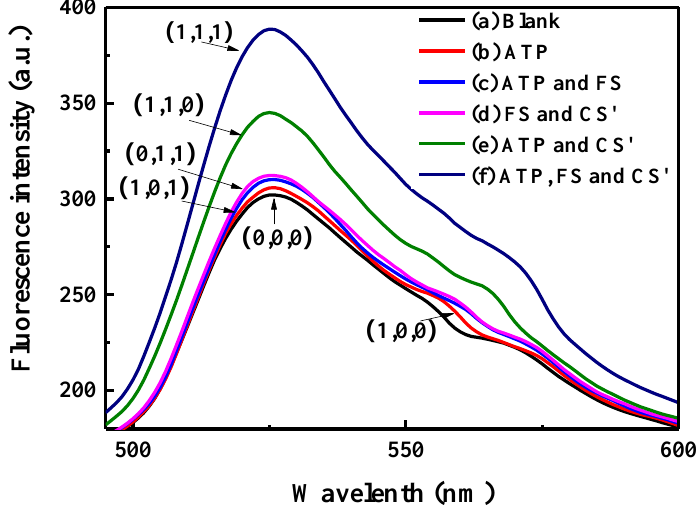
Figure 1. Fluorescence spectra of different mixtures: (a) DNA probe, GO, and PicoGreen; (b) DNA probe, GO, PicoGreen, and 500 nM ATP; (c) DNA probe, GO, PicoGreen, 500 nM ATP, and FS DNA; (d) DNA probe, GO, PicoGreen, FS DNA, and CS' DNA; (e) DNA probe, GO, PicoGreen, 500 nM ATP, and CS' DNA; (f) DNA probe, GO, PicoGreen, 500 nM ATP, FS DNA, and CS' DNA.